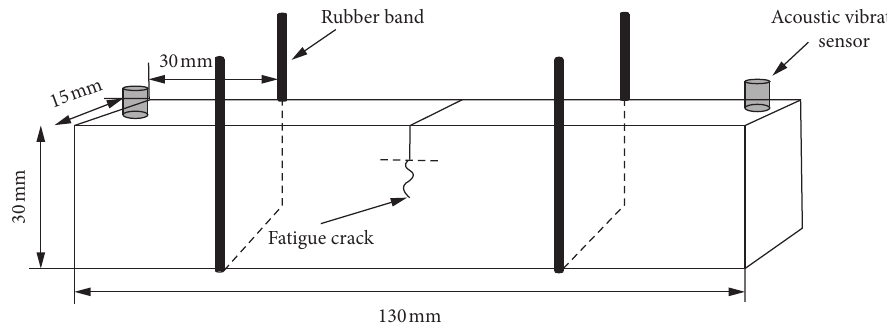
Figure 4: Schematic diagram of metal specimen suspension detection.